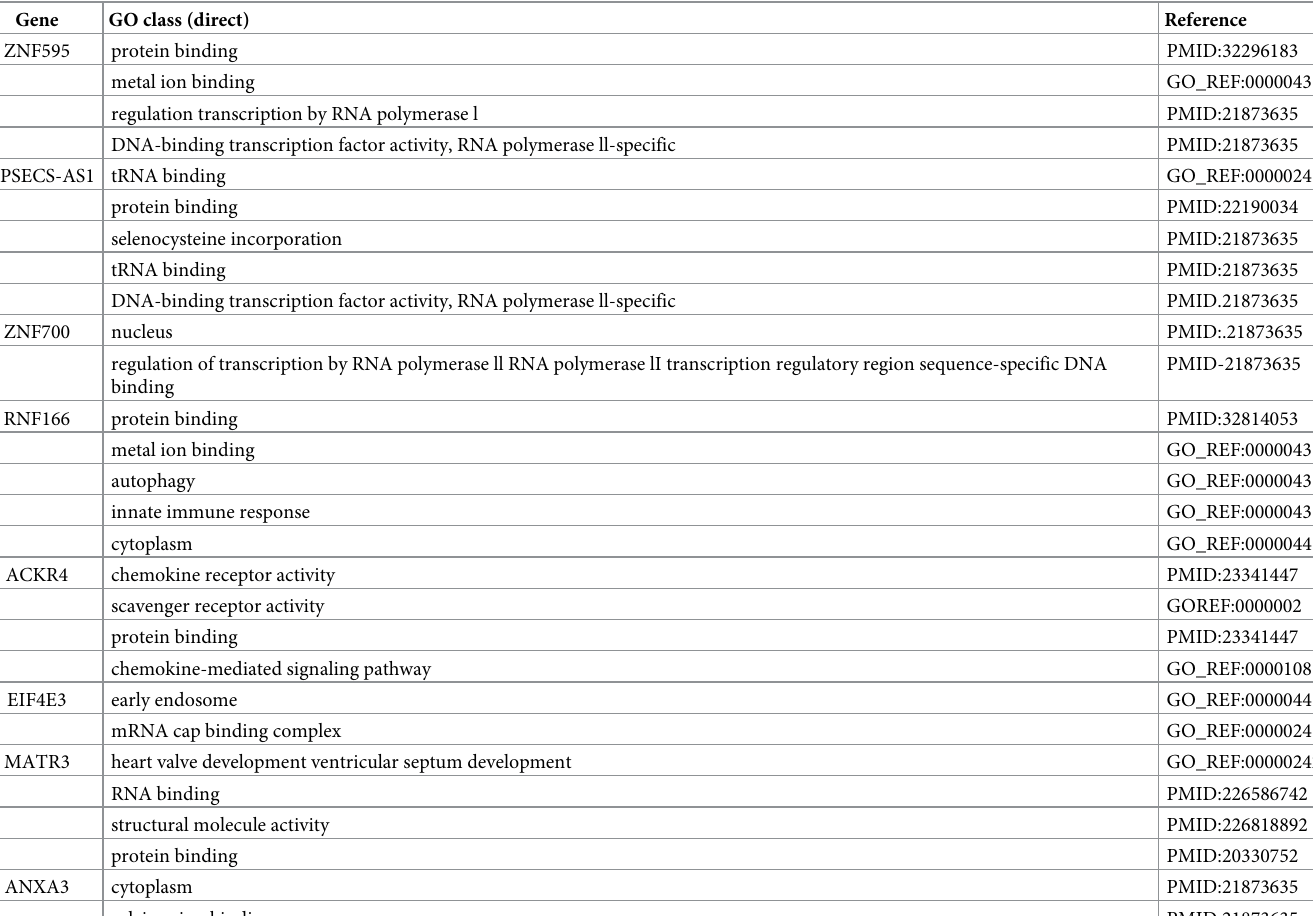
Table 1. The Gene Ontology (GO) terms enrichment for hub genes of the AF-related stroke.